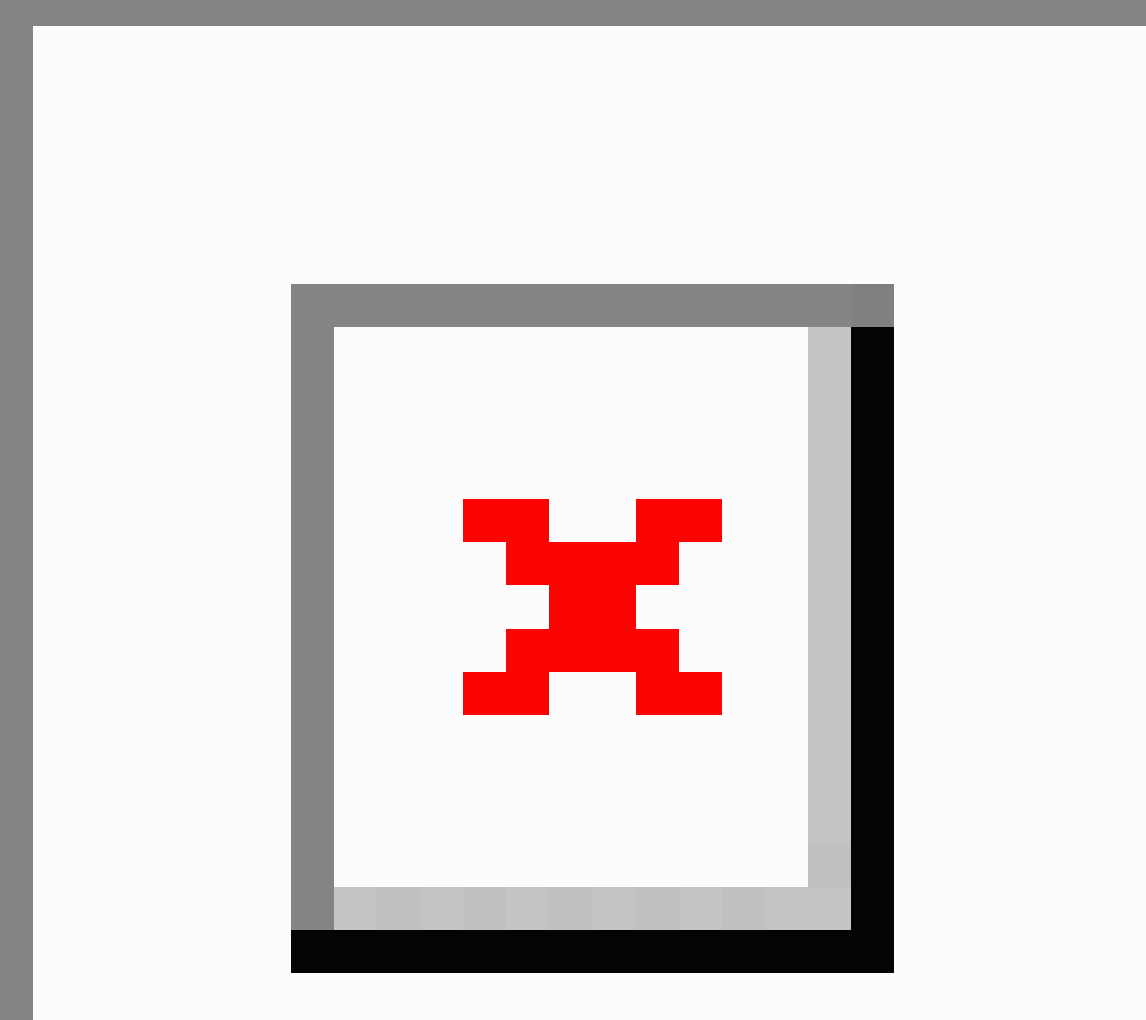
Figure 2. RPV registration by patient deprivation. The proportion of adult RRT patients registered for RPV is shown by patient rank deprivation (1-10, 10 is least deprived) for patients with postal codes in Scotland (filled diamonds) or England & Wales (open